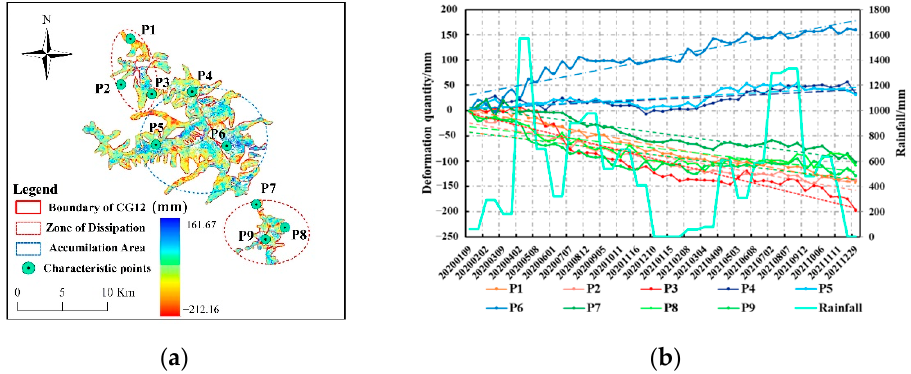
Figure 15. ( a ) Distribution of deformation characteristic points, ( b ) time series curves of characteristic points of glacier deformation in the Meili Snow Mountain.